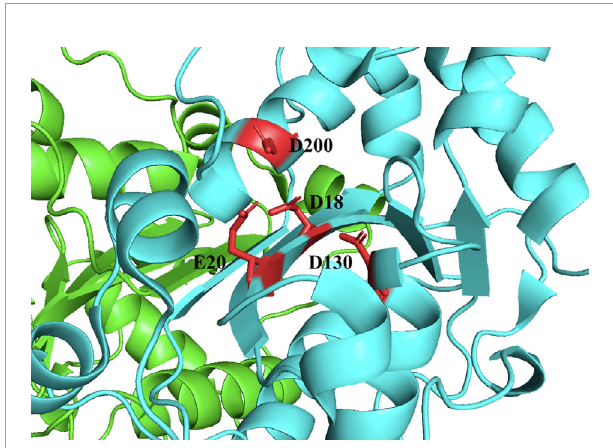
FIGURE 2 | TREX1 is a Member of the DEDD Family of Exonucleases. Structure includes only the TREX1 catalytic domain (1-242). Protomers are distinguished by green and cyan cartoons, and D18-E20-D130-D200 motif residues are shown as red sticks with black labels. Crystal structure was visualized in PyMOL using the PDB structure 3MXJ from ref